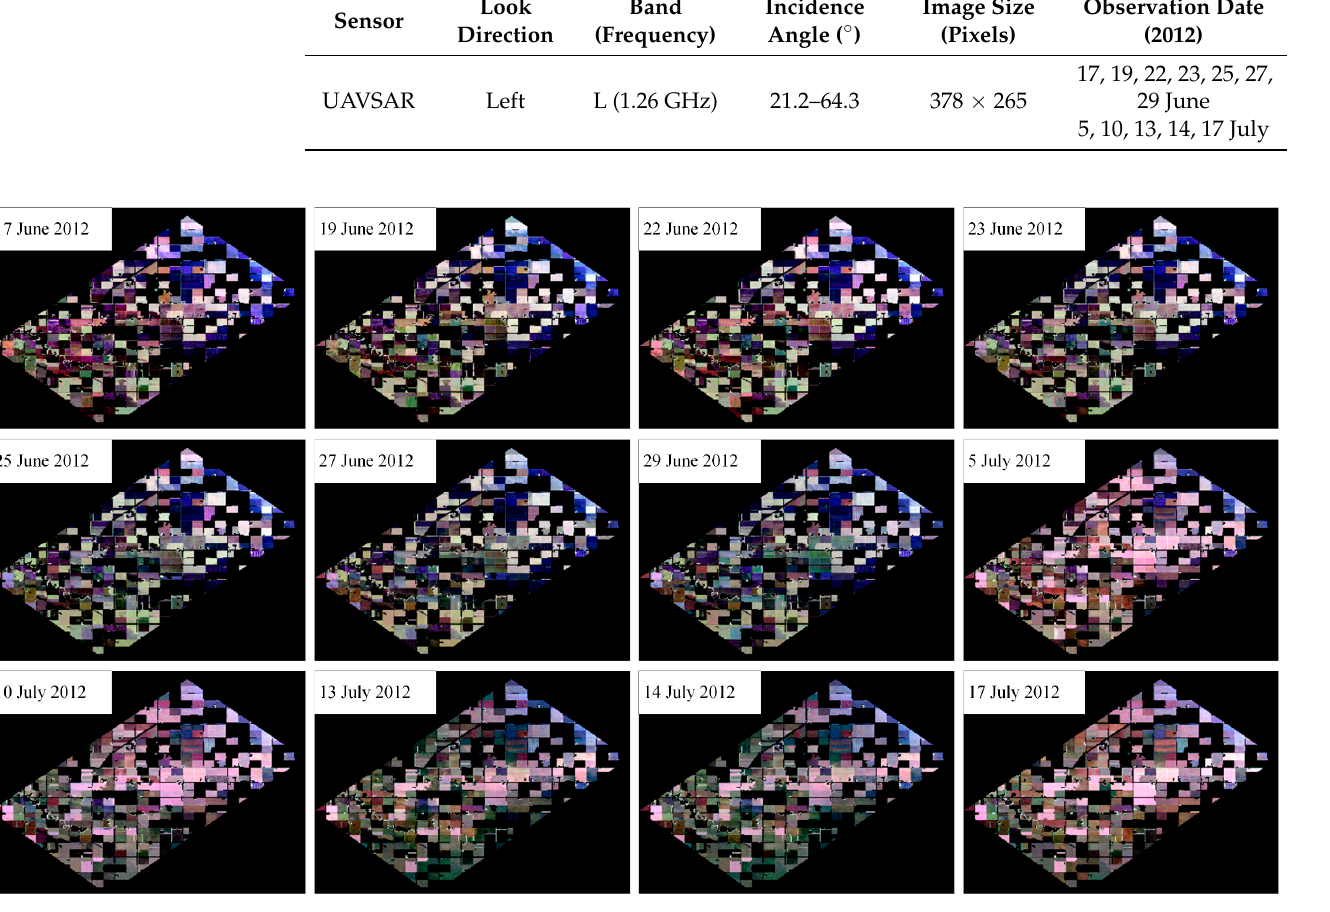
Figure 2. Pauli RGB images of the UAVSAR time-series images, with red | S HH − S VV | 2 , green 4 | S HV | 2 , and blue | S HH + S VV | 2 . Table 2. Number of pixels of each